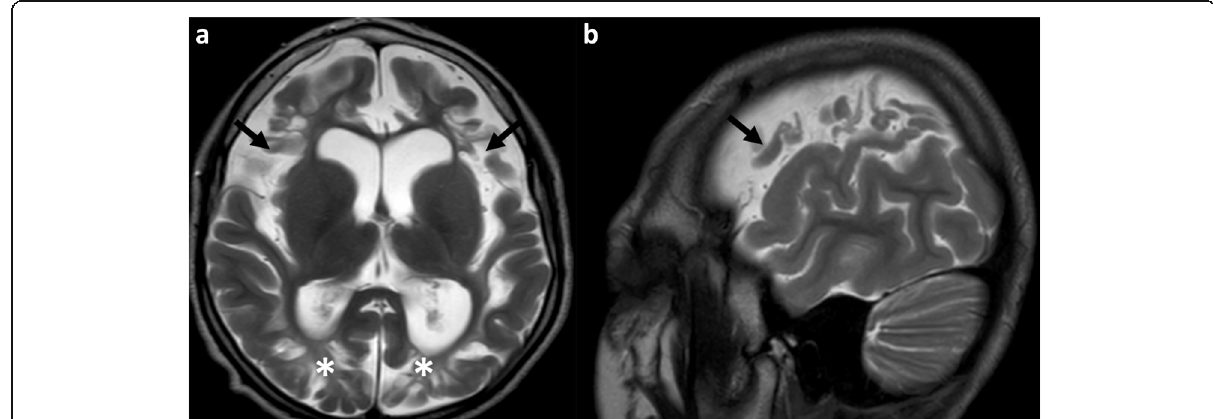
Fig. 6 a , b Axial ( a ) and sagittal ( b ) T2-weighted MRI in a 6-year-old boy who sustained a partial-prolonged hypoxic-ischaemic injury at term gestation, demonstrates extension of injury from the para-falcine portion of the parasagittal zones, inferiorly anteriorly along the Sylvian fissure (involving the peri-Sylvian zone), with involvement of the inferior aspect of the frontal lobe (arrows) and sparing of the superior temporal lobe. There is also ulegyria in the posterior inter-arterial watershed region (asterisks), visible on the axial T2 image ( a )